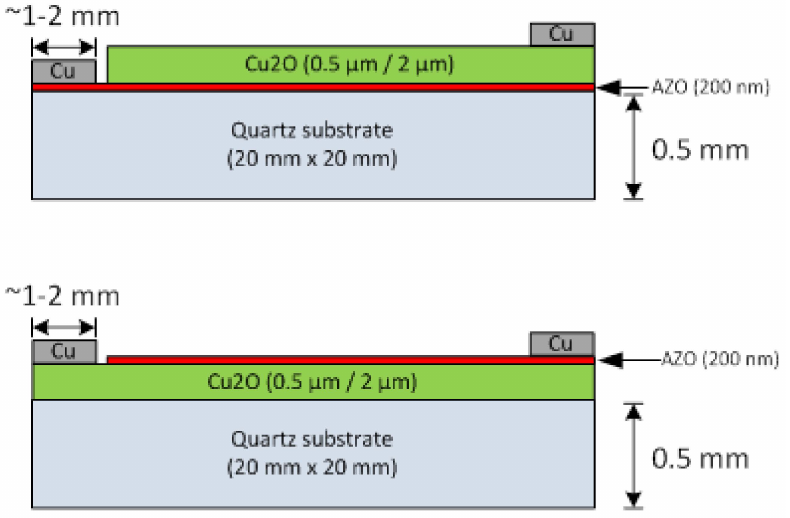
Figure 1. Solar top sub-cell patterns in the tandem structure